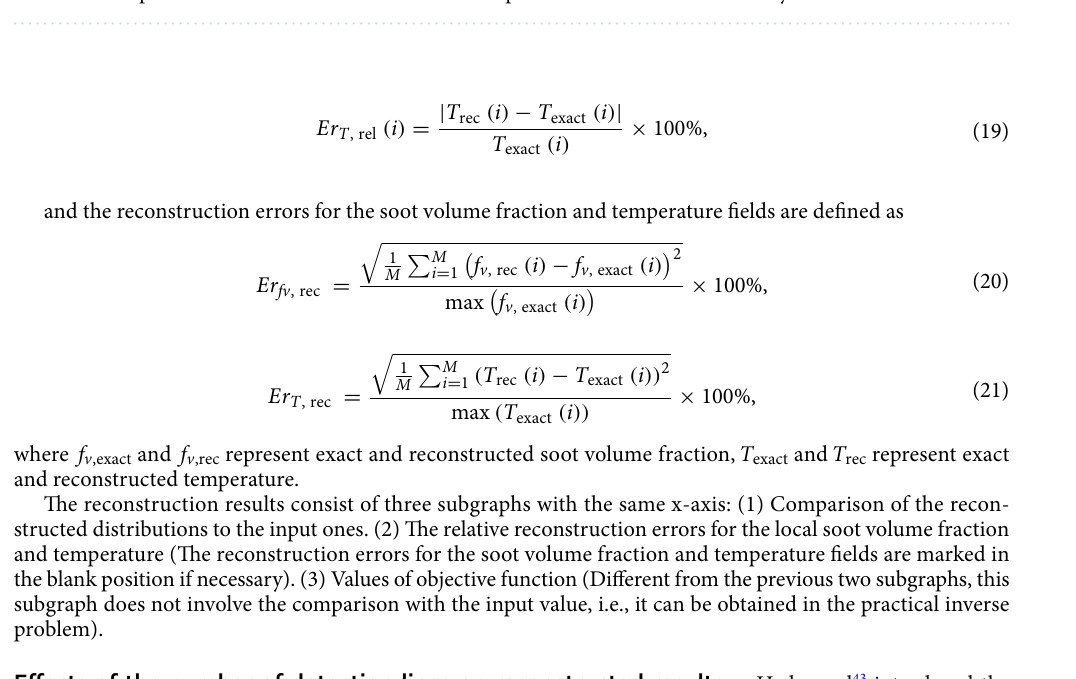
Table 3. The parameters that differ from the standard parameters of reconstruction